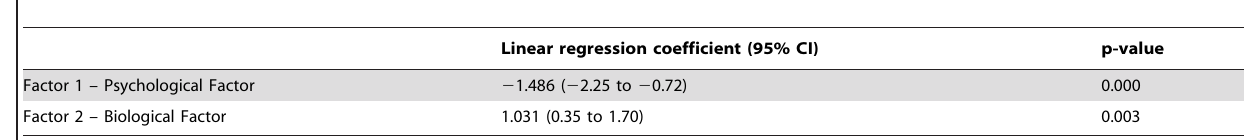
Table 4. Linear regression of extract factor from Primary Component Analysis